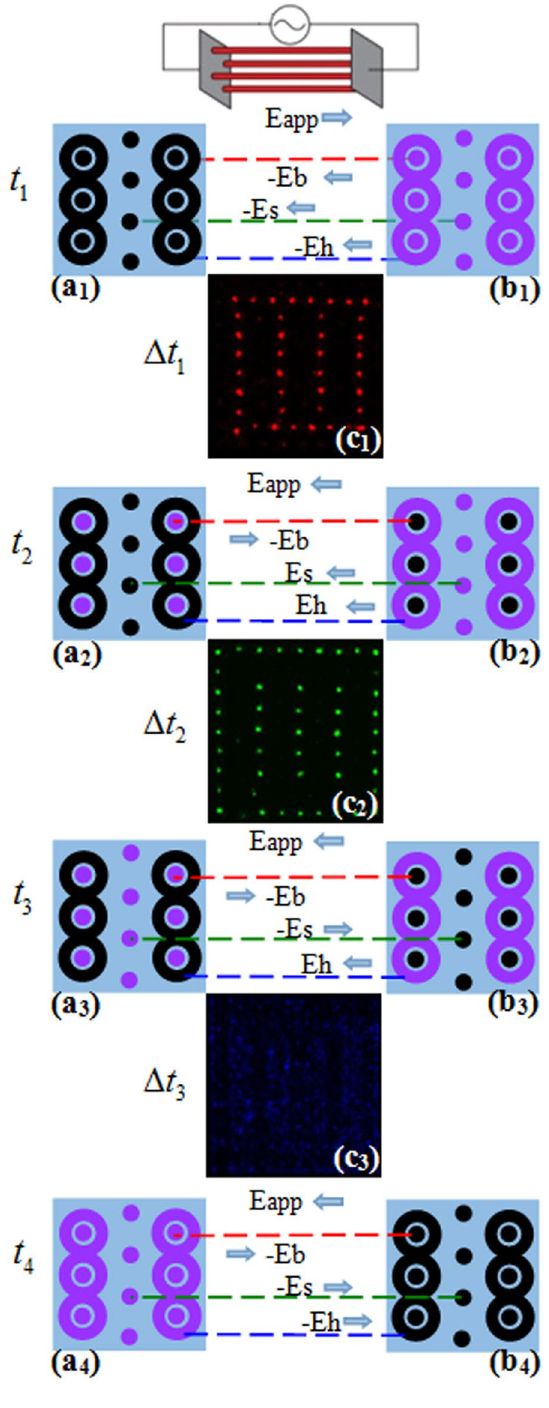
Figure 7. Time-resolved evolution sequence of the complex pattern with hexagonal lattice and white-eye stripe. (a 1 –a 4 ) One cell of the wall charges’ sublattice at different times on one side of dielectric surface. (b 1 –b 4 ) One cell of the wall charges’ sublattice at different times on the other side of dielectric surface (red represents the positive charge, black represents the negative charge). (c 1 –c 3 ) Images corresponding over a period of time are denoted in Fig. 2(a). (c 1 –c 3 ) Are pictures taken by ICCD camera which are integrated over 100 voltage cycles. A simplified circuit is given in the upper part of this figure. The applied electric field and the internal electric fields induced by big spots, small spots and halos are named as E app , E b , E s and E h , respectively. The negative sign is added to E b , E s and E h when they are reversed to E app